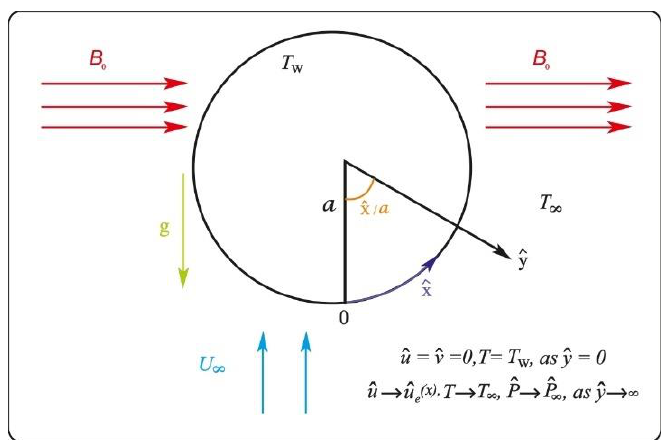
Figure 1. Layout and geometrical coordinates